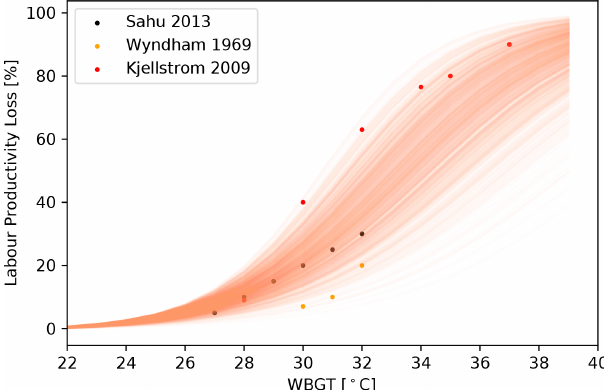
Figure 3. Distribution of impact functions describing the relation- ship between WBGT and percentage of labour productivity loss for people working at a moderate physical